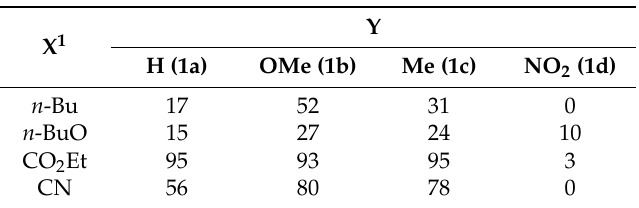
Table 1. Cycloaddition between nitrilimines 1 and 1-X 1 -ethenes (reaction group (RG)-I) giving 5-(X 1 )- pyrazolines 2 (% yields).